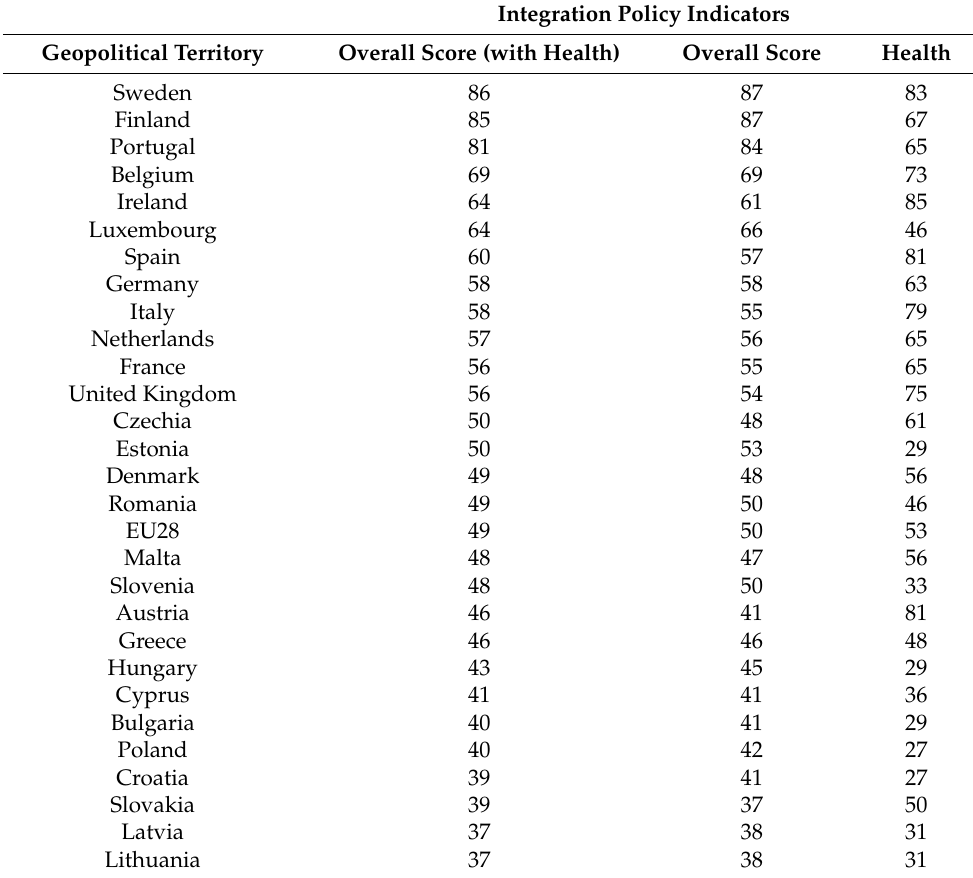
Table 2. Migrant Integration Policy, European Union Countries (EU28), 2019 (index 0–100). Integration Policy Indicators Geopolitical Territory Overall Score (with